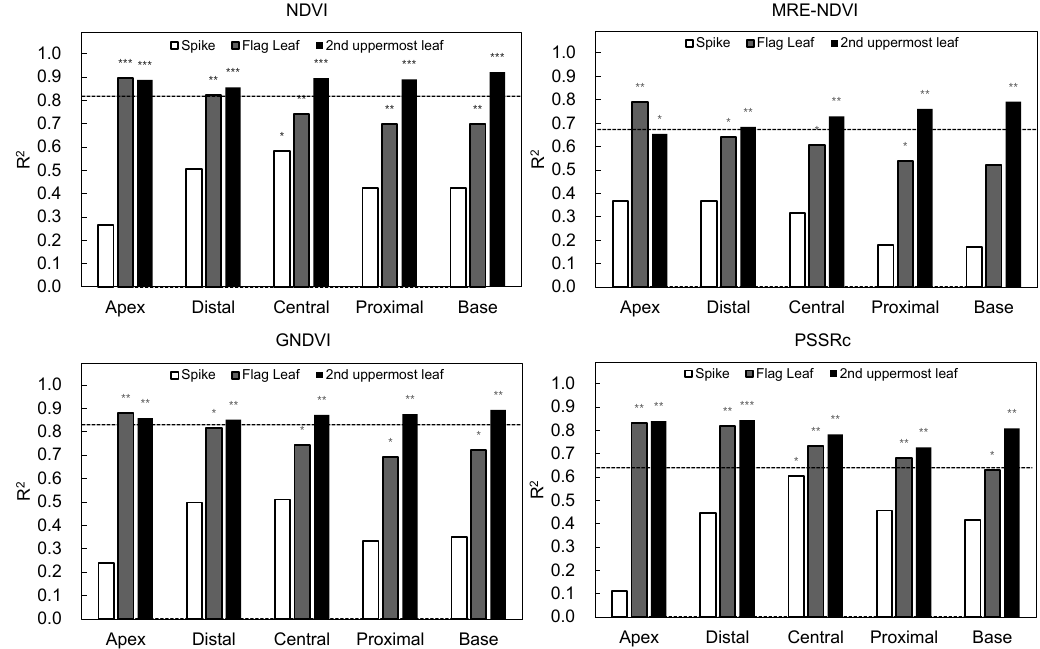
Figure 6. Variation of vegetation indices by the nitrogen levels. Vegetation indices were calculated with the spectral data of five different regions of the second uppermost leaf. In the box plots, the bottom and top of the box describe the 25th and 75th percentiles, the band near the middle of the box is the 50th percentile (the median); the ends of the whiskers represent the minimum and maximum of the data. The black circle dots indicate outliers. Table 1. Standard deviation of the reflectances measured in organs at different wavelengths.